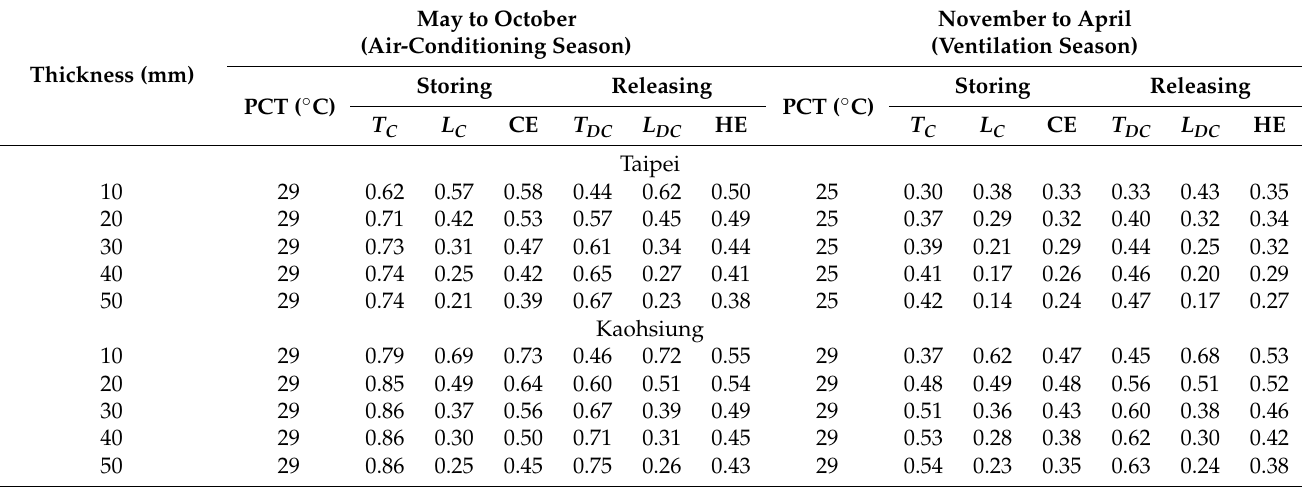
Table 4. Corresponding efficiency coefficients for PCM roofs for school buildings in Taiwan.